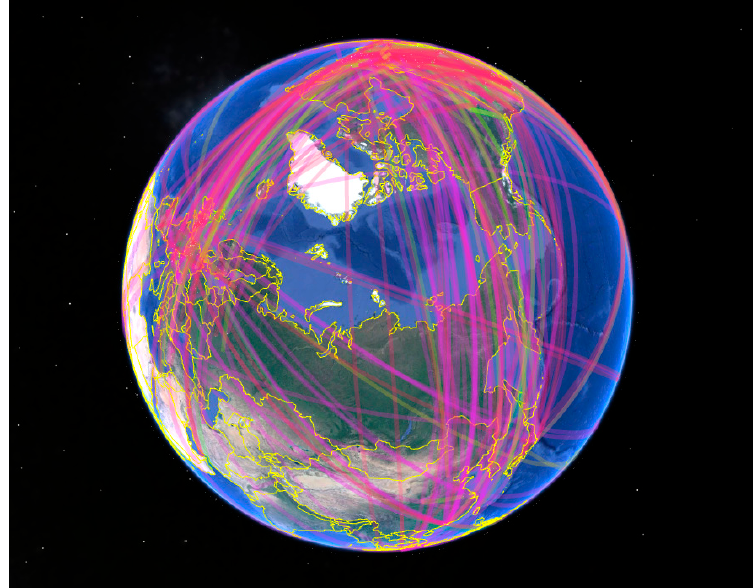
Figure 2. The global citation links in SLA.